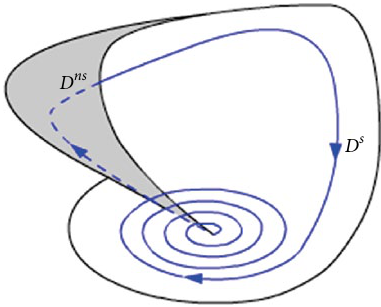
Fig. 14. Interpretation of the texture formed on the surface of the particle of the intersection between normal planes of velocity vectors (fragment)